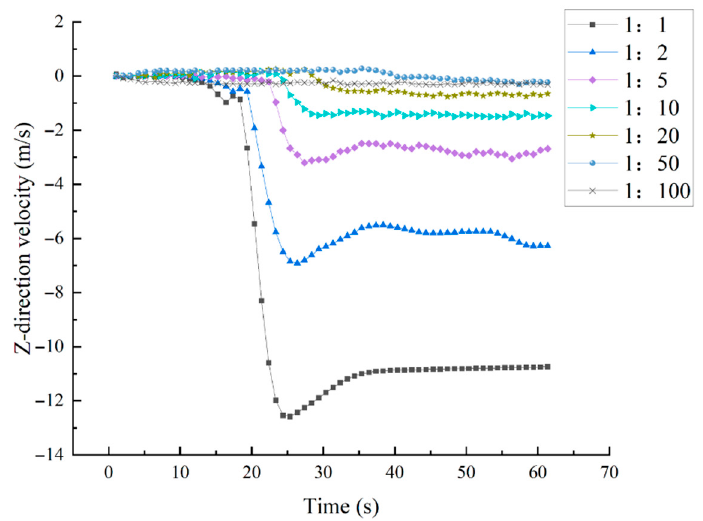
Figure 6. Wind speed component in the z-direction under different similar scale conditions.